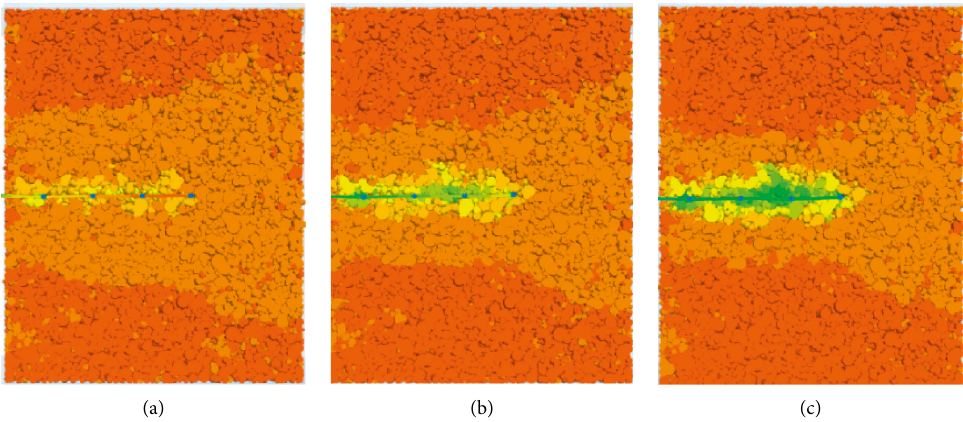
Figure 9: Evolution of the influencing zone under a vertical load of 150kPa. (a) 5mm, (b) 10mm, and (c) 15 mm.